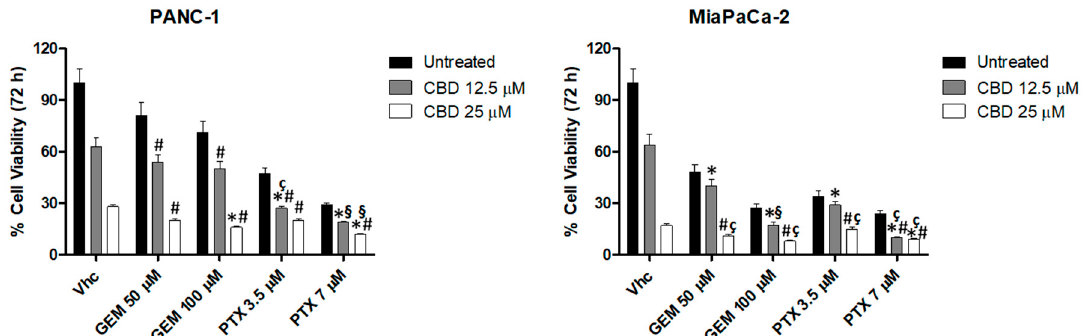
Figure 6. CBD increases the cytotoxic effect of chemotherapeutic drugs in PDAC cell lines. CBD increases the cytotoxic effect of chemotherapeutic drugs in PDAC cell lines. Cell viability was determined in PDAC cell lines by MTT assay. Cells were treated for 72 h with CBD, alone and in combination with different doses of GEM and PTX. Data shown are expressed as mean ± SE of three separate experiments. * p < 0.05 vs. CBD alone, # p < 0.05 vs. chemotherapeutic drug alone, § for additive effect, ç for synergistic effect.